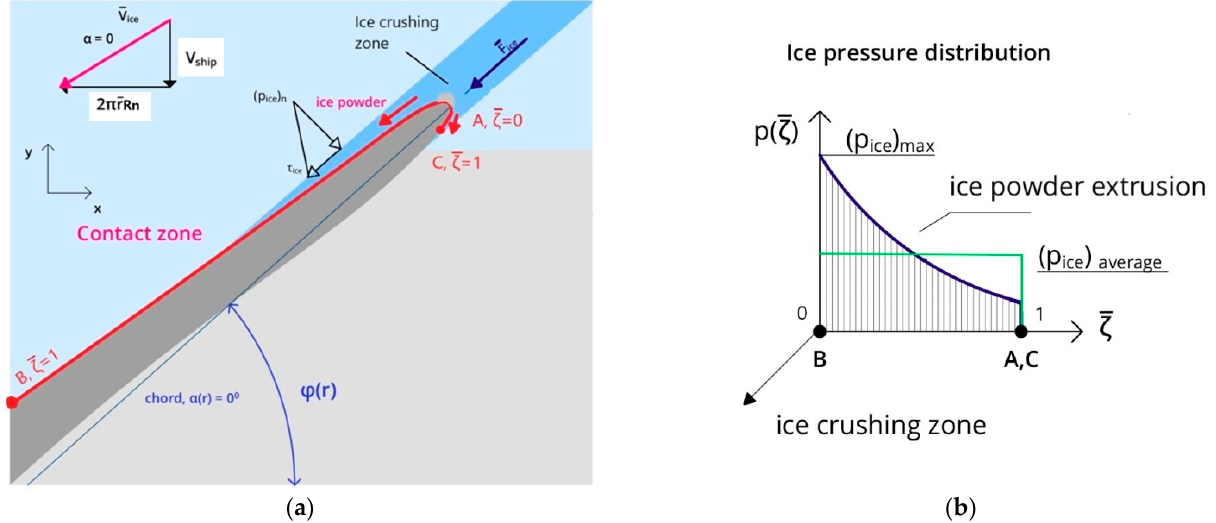
Figure 5. ( a ) Scheme of the profile/ice contact for zero attack angle; ( b ) ice pressure distribution along the contact zone. AB—contact zone from the suction side; BC—contact zone from the pressure side; ζ ∈ [ 0, 1 ] , 0—beginning of a contact zone; 1—end of a contact zone (see also Figure 3 for more details); α —attack angle; ϕ —pitch angle; V ship —ship speed; V ice —ice contact speed; n —propeller speed; r —relative radius of propeller; R —propeller radius; ( p ice ) average —average ice pressure.